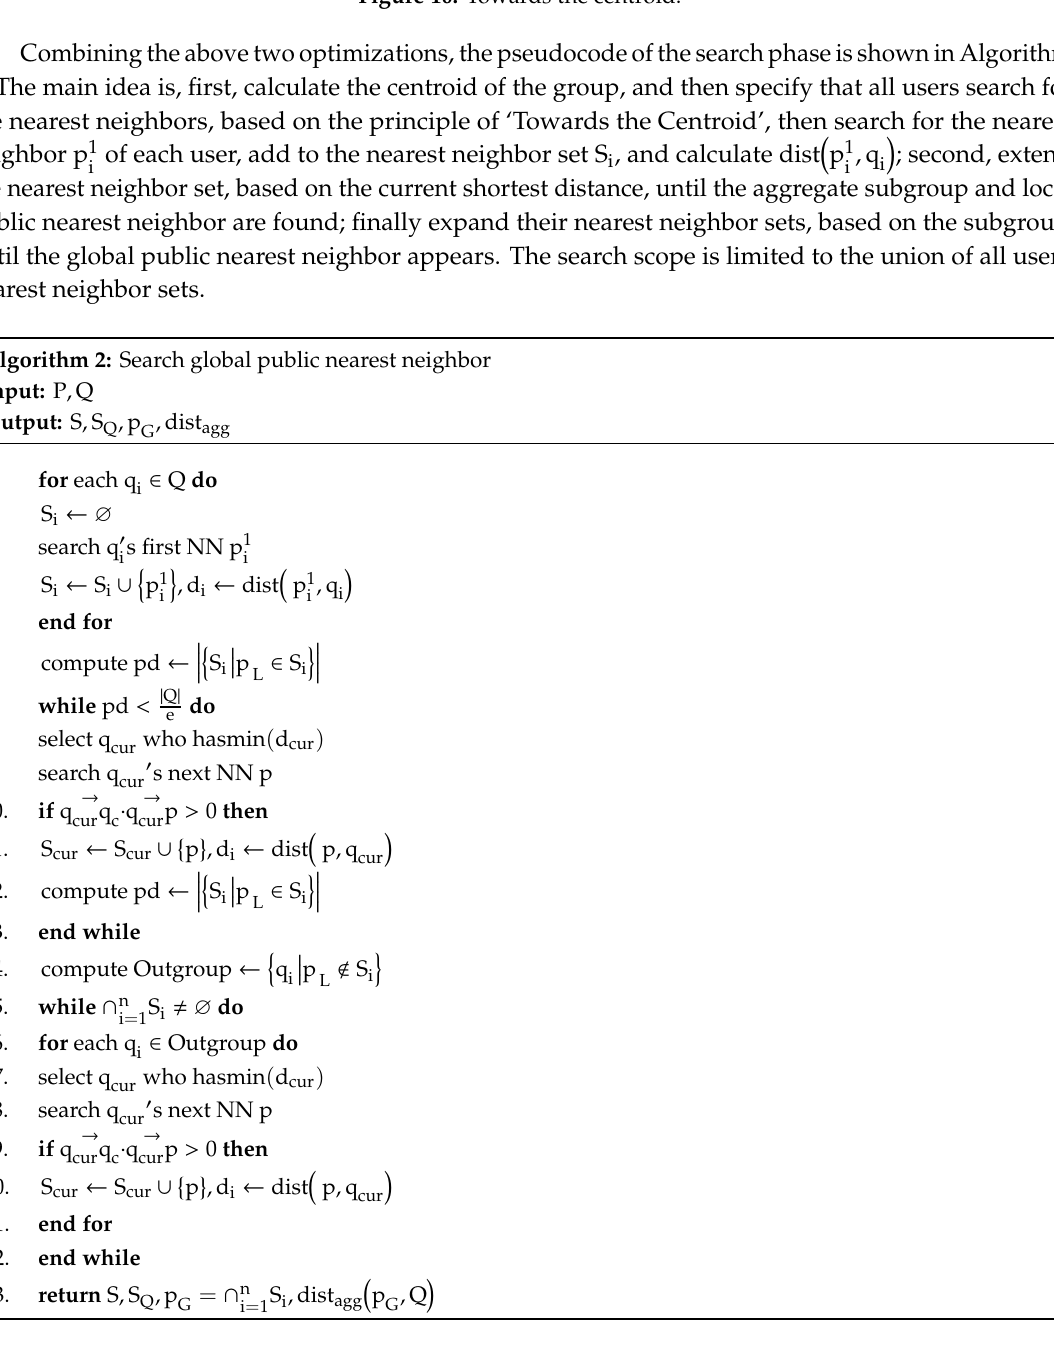
Figure 10. Towards the centroid.